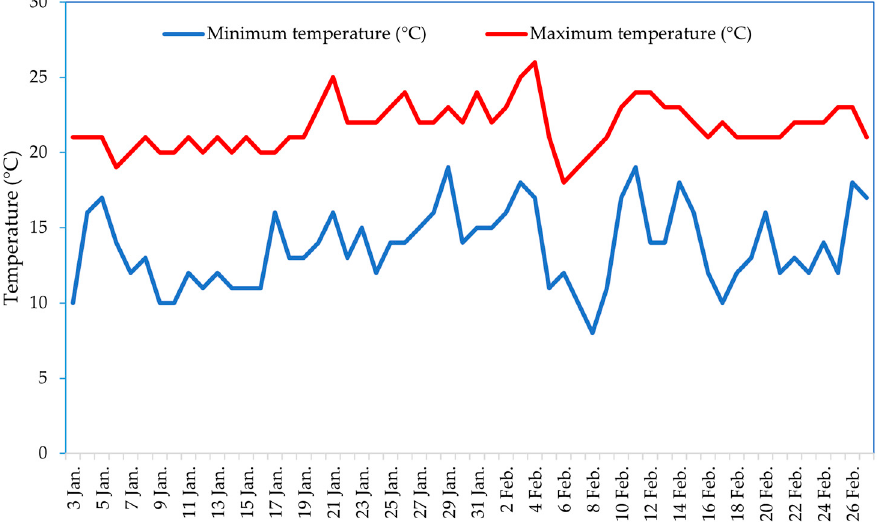
Figure 1. Daily minimum and maximum temperature from 3 January to 26 February at the experimental site.